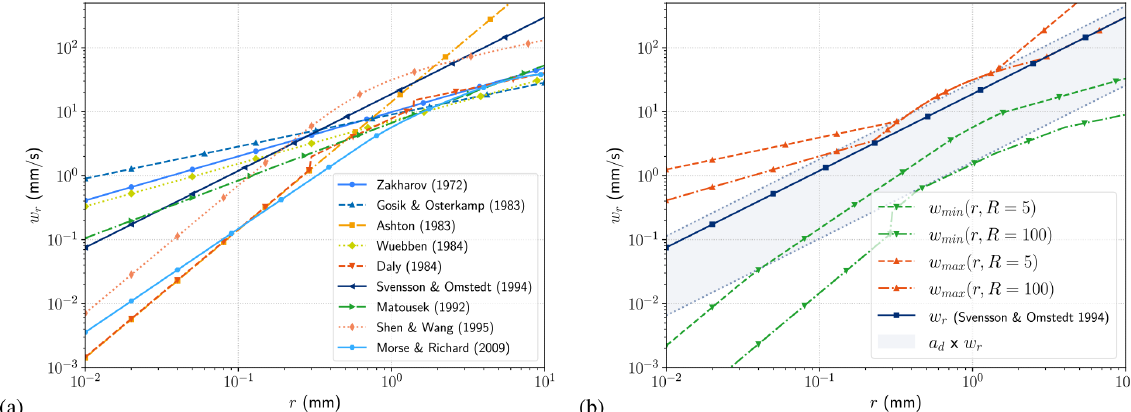
Figure 4. Comparison of frazil rise velocity models with R = 10 (a) and the rise velocity envelope chosen for the uncertainty analysis (b) (Zacharov et al., 1972; Gosink and Osterkamp, 1983; Ashton, 1983; Wuebben, 1984; Daly, 1984; Svensson and Omstedt, 1994; Matoušek, 1992; Shen and Wang, 1995; Morse and Richard, 2009). Table 2. Uncertain parameters of the frazil ice models and their PDFs. Parameter Unit Description Uncertainty interval C